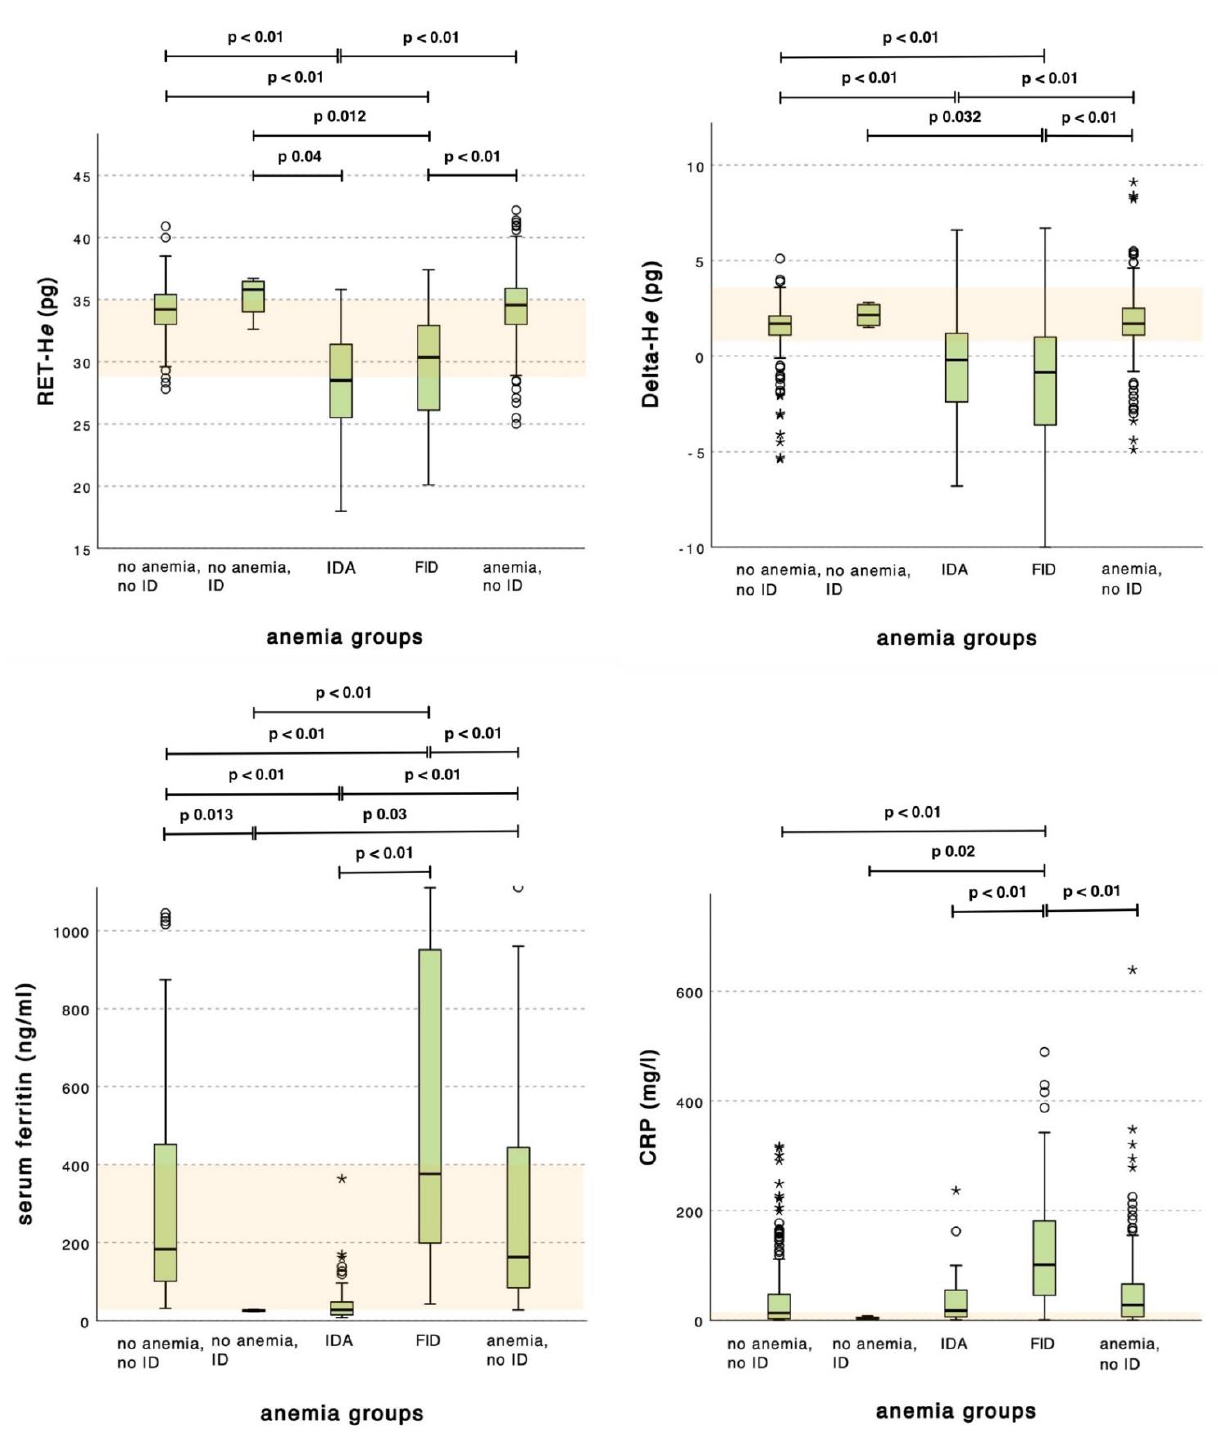
Figure 3. Ability of RET-H e , Delta-H e serum ferritin, and CRP to discriminate between anemic, iron-deficient, and inflammatory states. Group comparison by Kruskal–Wallis. The colored band marks the reference range; , mild outliers (value between 1.5 to 3 IQR from the box); ∗ , extreme outliers (value more than 3 IQR from the box); p, p -value.